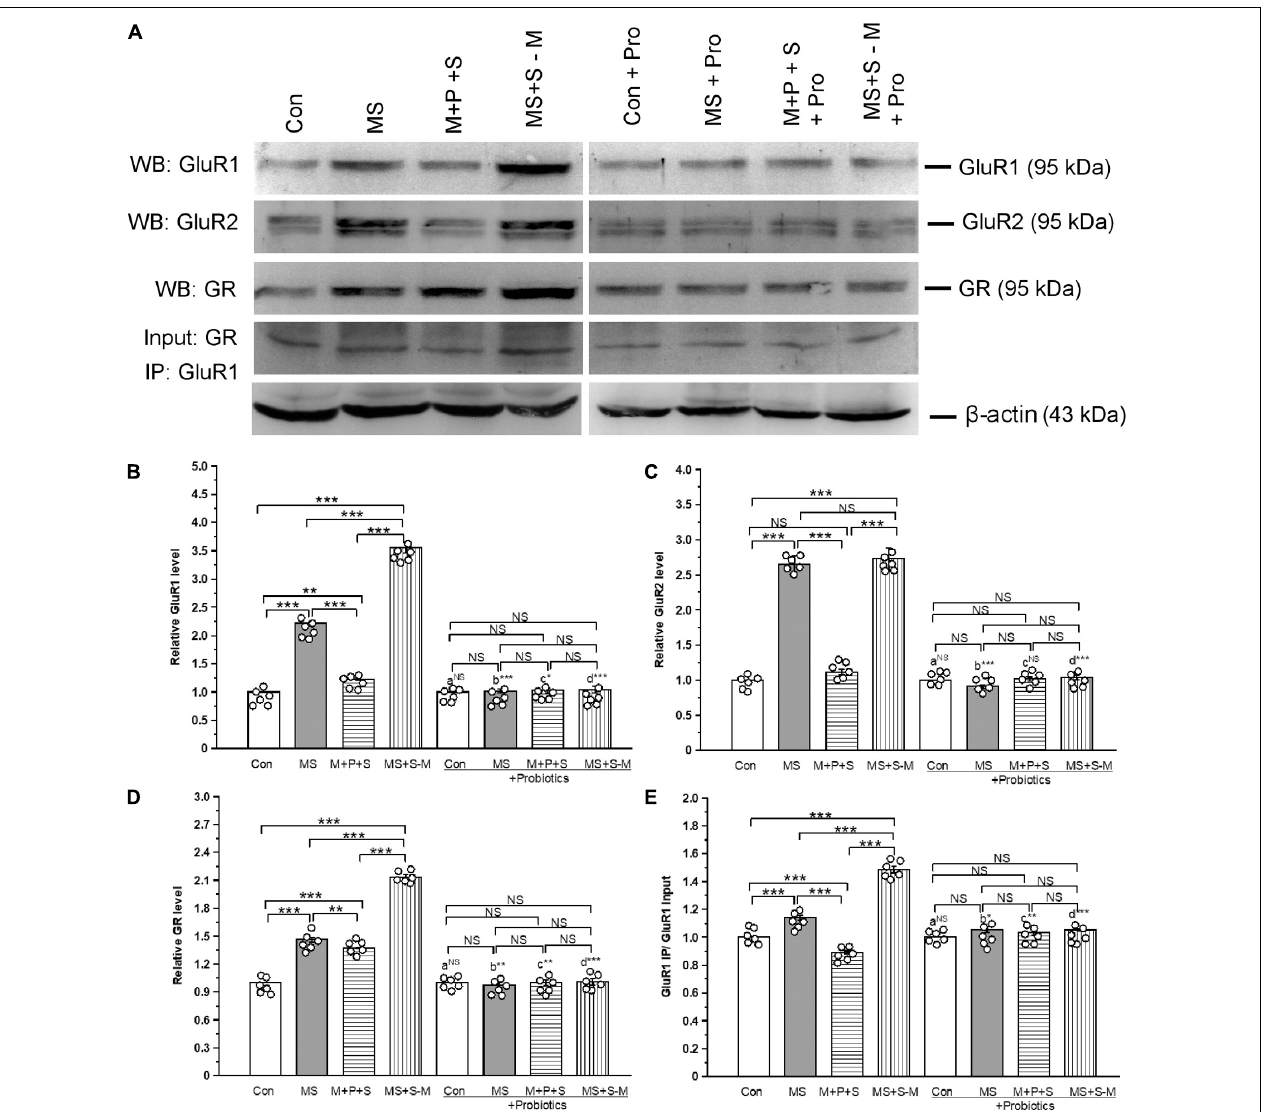
FIGURE 8 | Early life SSE induced alteration in glutamate receptors (GluR1 and GluR2) and its interaction with glucocorticoid receptors (GR) prevented by lactobacillus supplementation. (A) Representative western blots showing immunoreactivity to GluR1, GluR2, GR, and GluR1 + GR Co-IP. Estimated level of GluR1 (B) , GluR2 (C) , GR (D) , and Co-IP of GluR1 with GR (E) . Values are presented as mean ± SEM. Significant differences between groups are indicated by *** P < 0.001, ** P < 0.01, * P < 0.05; a: con vs. con + Pro; b: MS vs. MS + Pro; c: M + P + S vs. M + P + S + Pro; d: MS+S–M vs. MS+S–M + Pro; NS, not